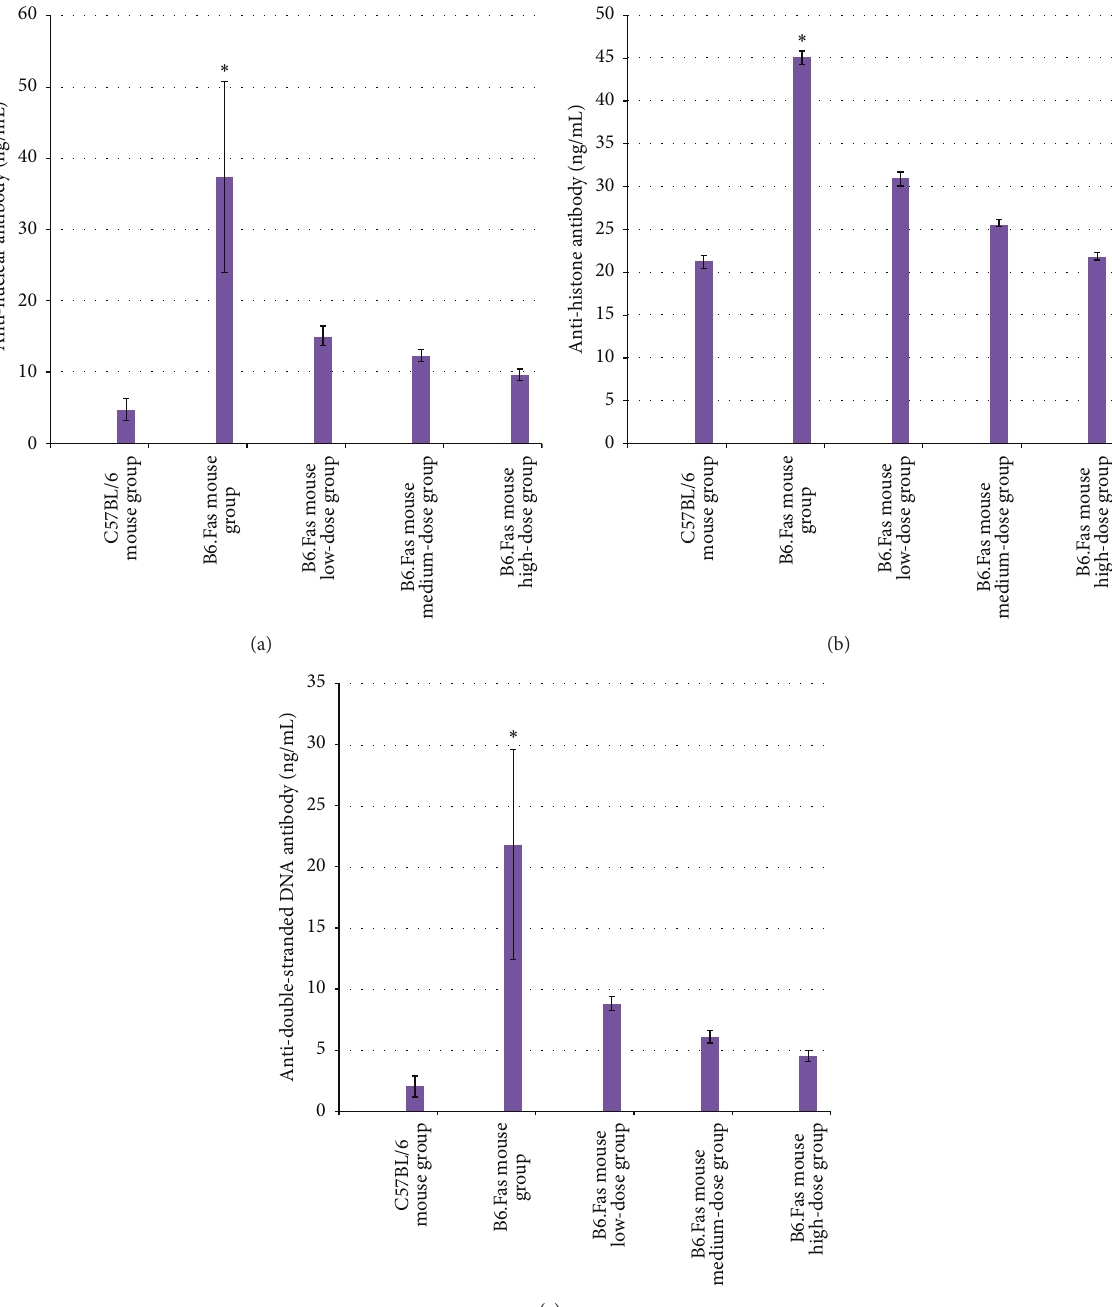
Figure 2: (a) Anti-nuclear antibody testing in the five groups. The results are expressed as the mean ± standard deviation ( 𝑛 = 10 ). (b) Anti- histone antibody testing in the five groups. The results are expressed as the mean ± standard deviation ( 𝑛 = 10 ). (c) Anti-double-stranded DNA antibody testing in the five groups. The results are expressed as the mean ± standard deviation ( 𝑛 = 10 ). ∗ 𝑃 < 0.01 compared to other